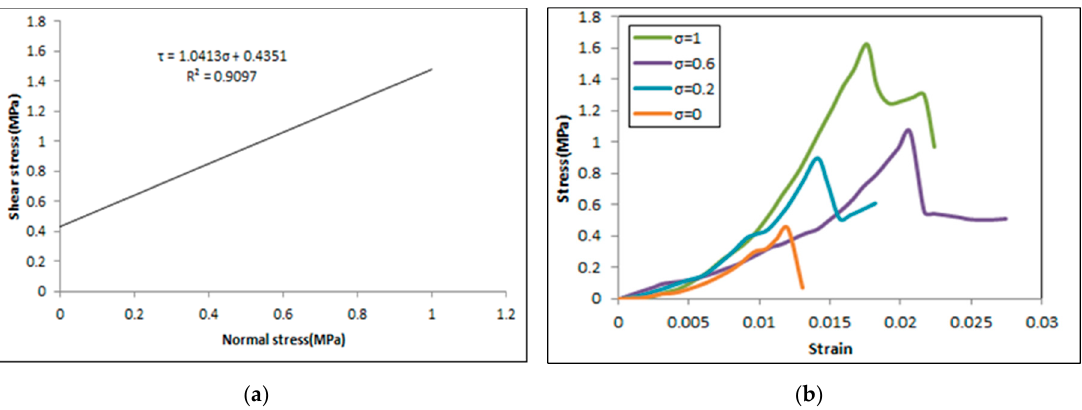
Figure 11. ( a ) Relationship between maximum shear stress and normal stress of shear triplet test; ( b ) stress–strain curves for various pre-compression of walls.